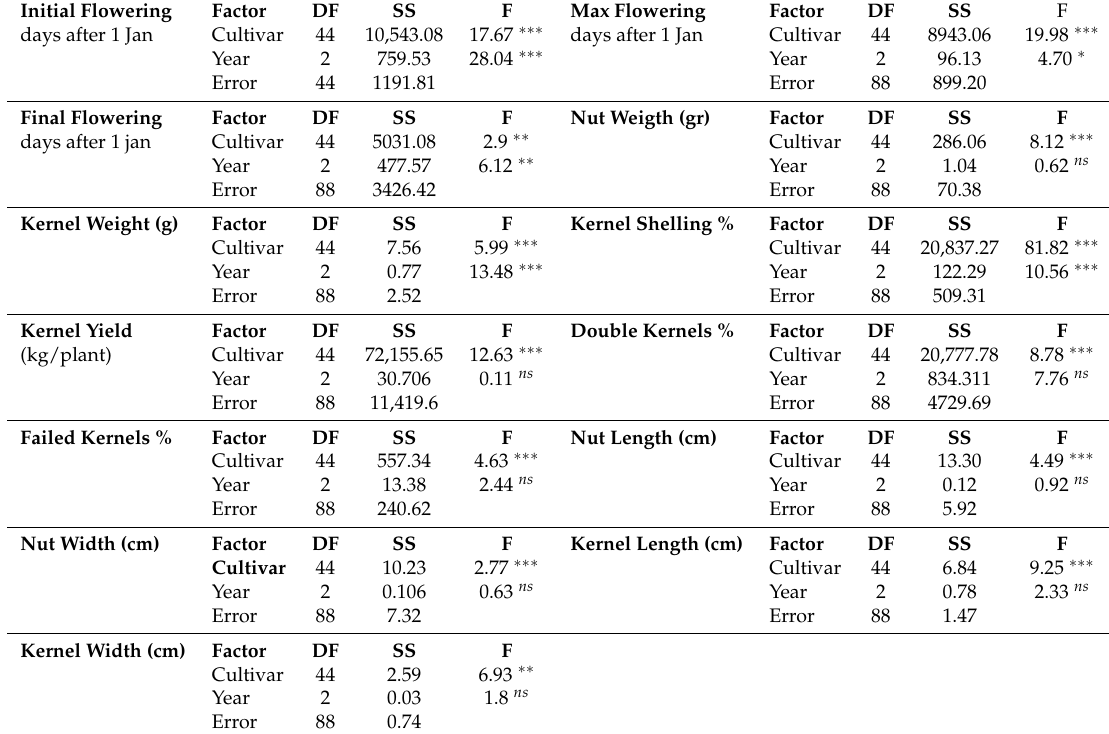
Table 2. Analysis of variance of flowering, nut- and kernel- related traits. *** corresponds to p < 0.001 , ** to p < 0.01, ns to p >